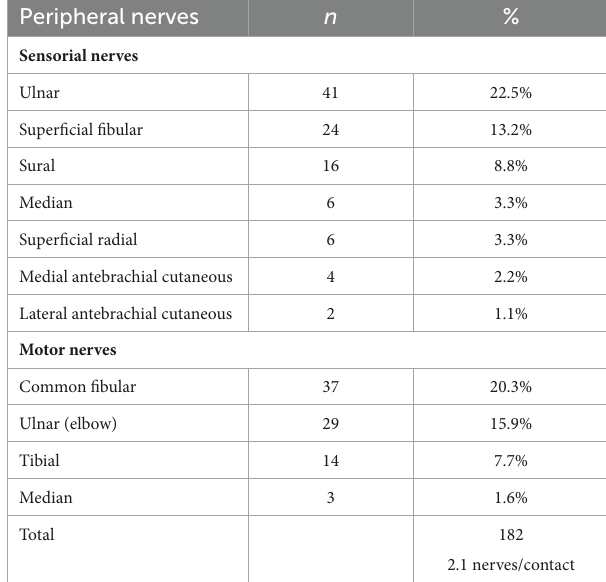
TABLE 2 Distribution of the electroneuromyographic pattern in seropositive household contacts of leprosy patients.